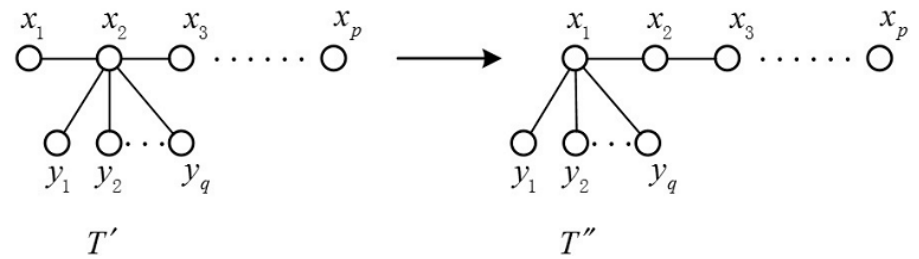
Figure 2: The trees T ′ and T